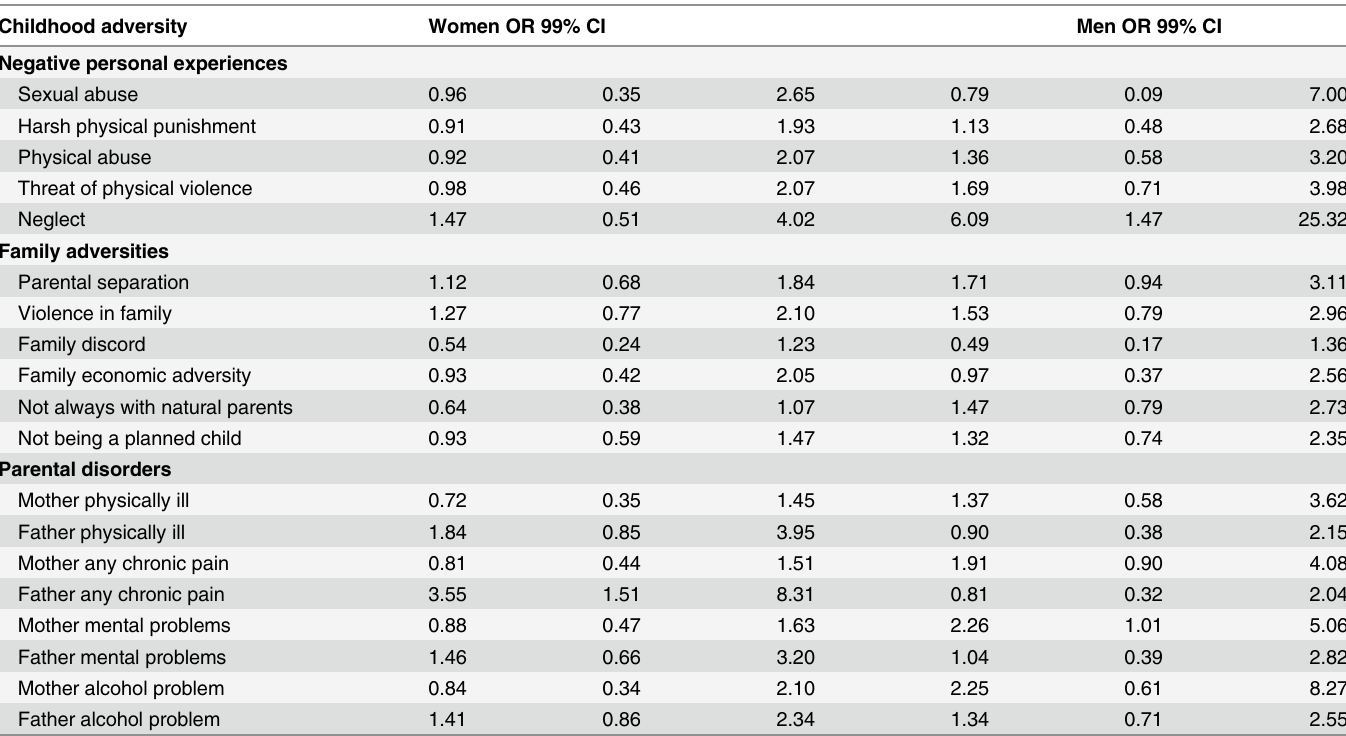
Table 3. Bivariate associations between headache and childhood risk